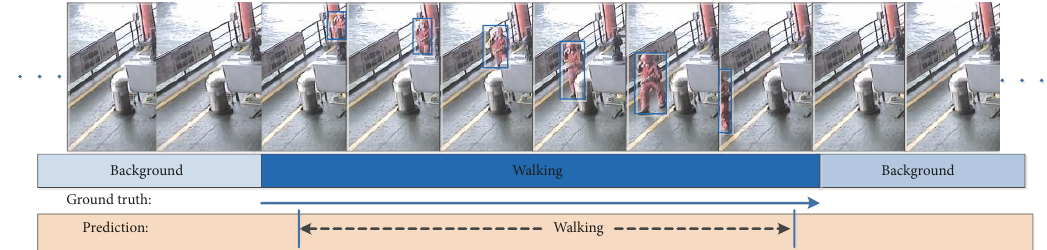
Figure 7: Scene detection of two persons walking.